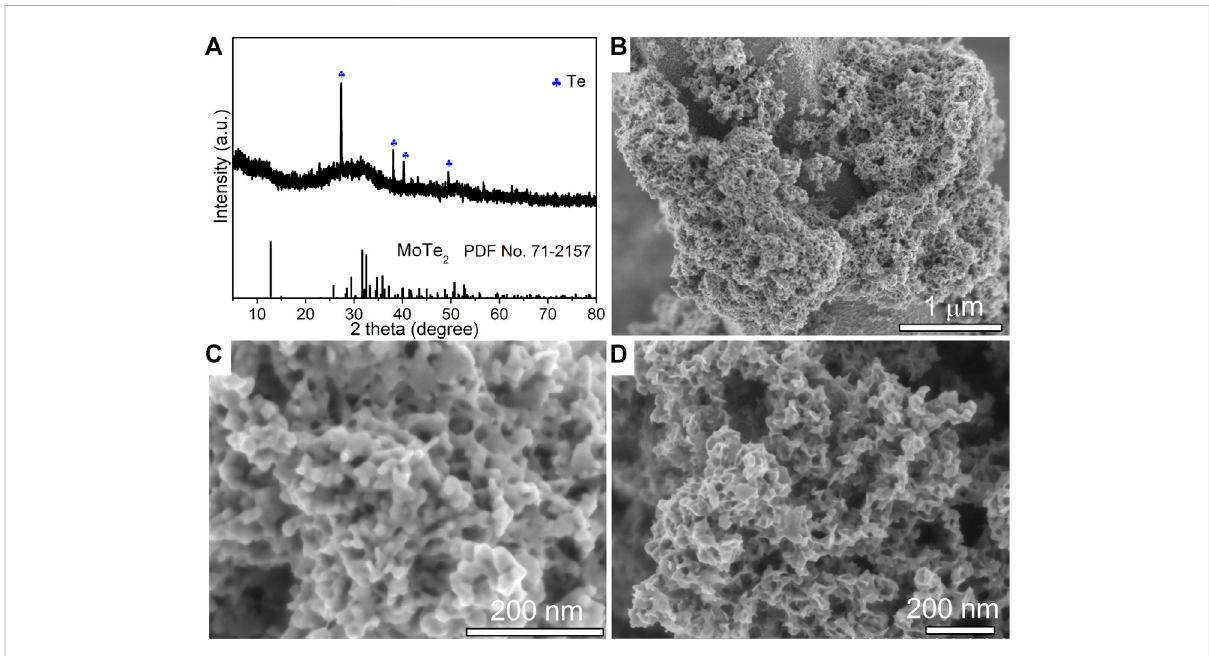
FIGURE 3 XRD pattern (A) , low-resolution SEM image (B) and high-resolution SEM images (C,D) of as-synthesized MoTe 2 nanoparticles. The insets show the EDX analysis collected from the corresponding objects.